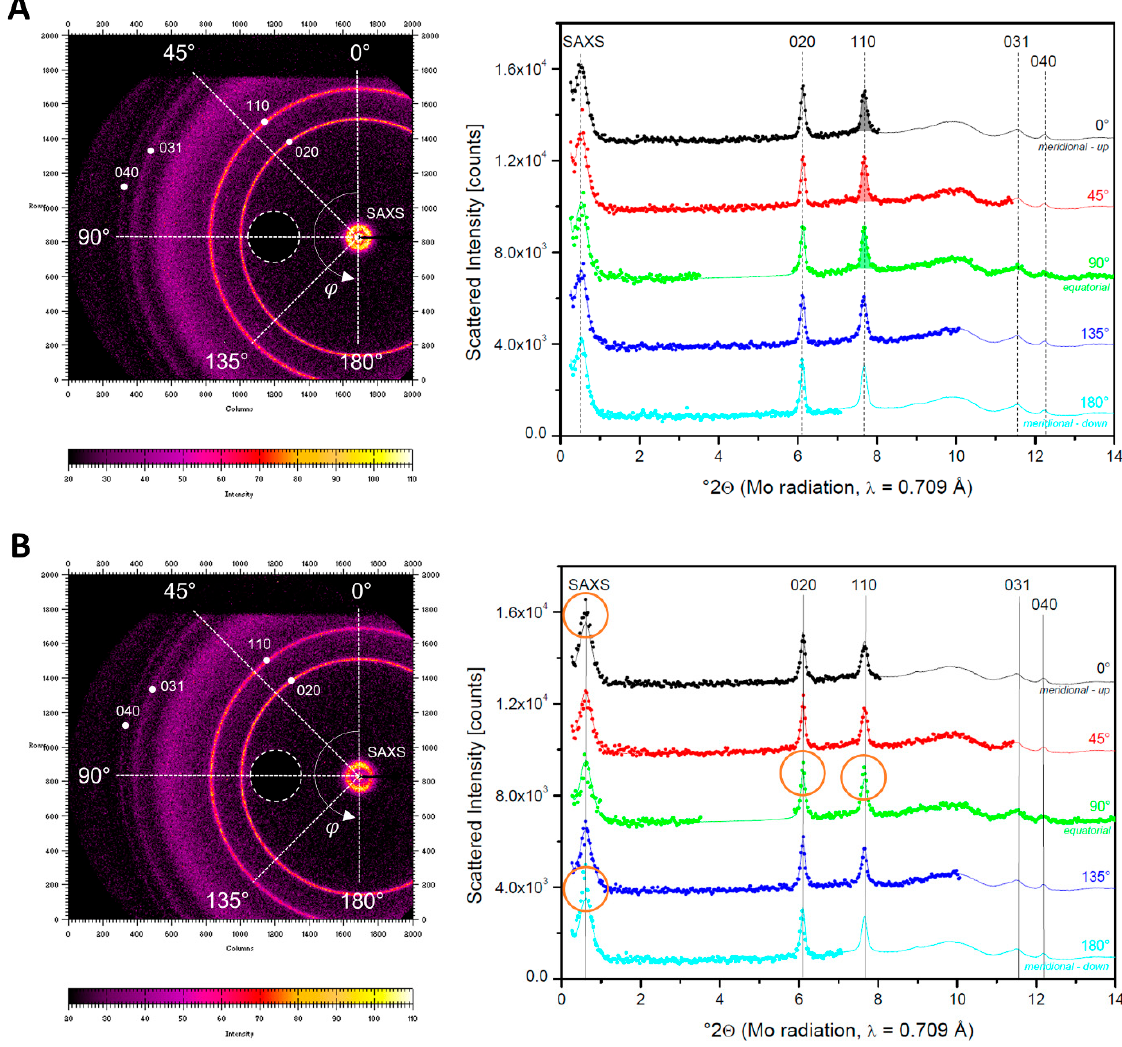
Figure 9. 2D scattering patterns of samples M = 80 ◦ C ( A ) and M = 40 ◦ C ( B ) with an indication of the PHB typical reflections with Miller indices ( left ) and corresponding individual scans along different φ directions ( right ). The white circled regions in the 2D scattering patterns are detector blind regions.